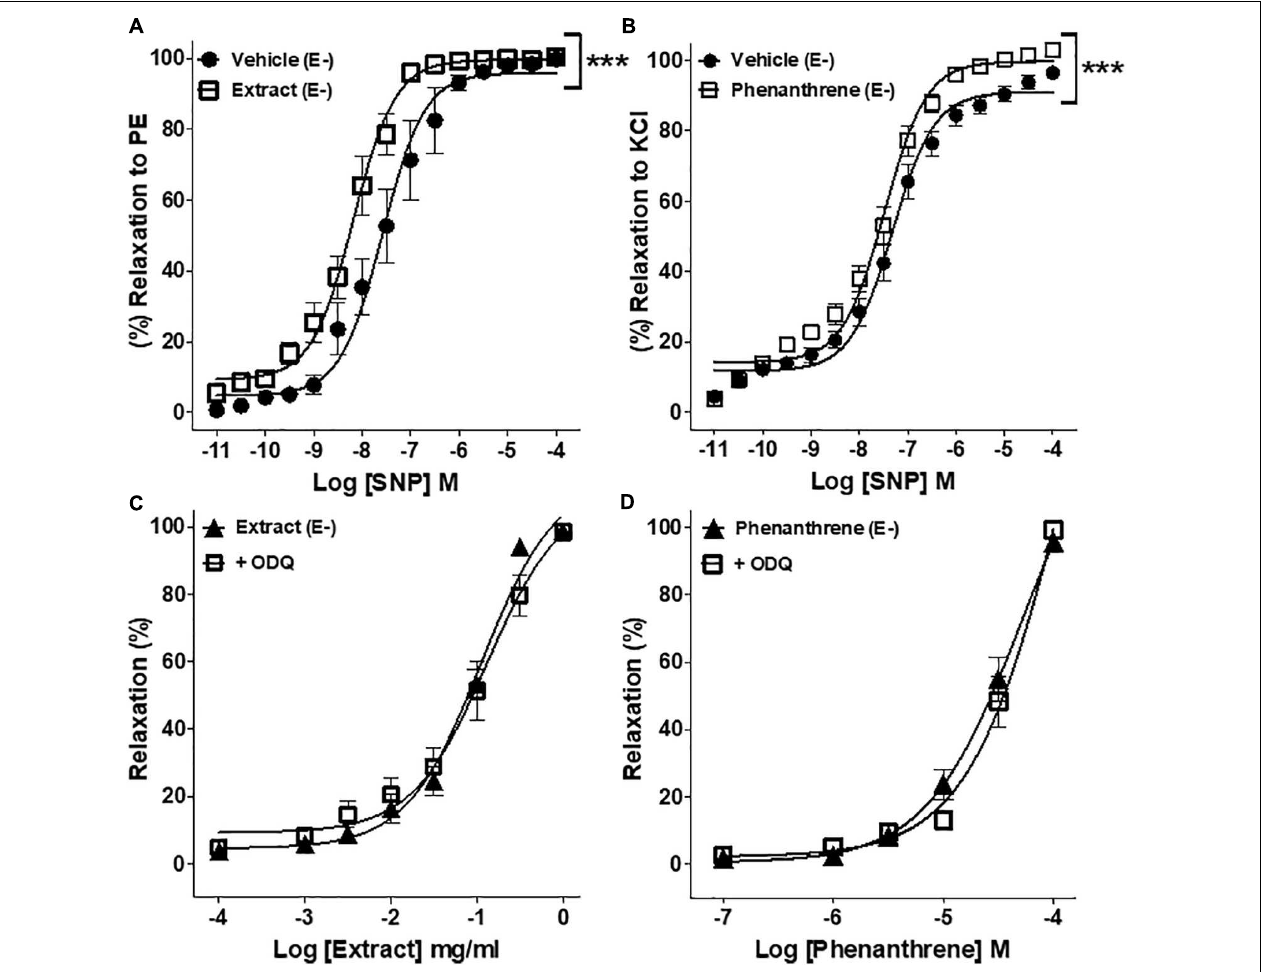
FIGURE 4 | Effect of EM extract or phenanthrene on sGC/cGMP-induced relaxation. Endothelium-denuded (E − ) mesenteric rings pretreated with 125 µ g/ml EM or vehicle and pre-contracted with 10 − 5 M PE (A) , pretreated with 35 µ M phenanthrene or vehicle and pre-contracted with 100 mM KCl (B) followed by relaxations with cumulative concentrations of SNP, a nitric oxide donor. EM extract (C) or phenanthrene (D) -induced relaxation of denuded (E − ) rings pre-contracted with 10 − 5 M PE and pretreated with 10 − 5 M ODQ, sGC inhibitor. Values are means ± SEM of n individual arteries. ∗ p < 0.05, ∗∗ p < 0.01, ∗∗∗ p < 0.001 vs. vehicle (A,B) , vs. Extract (E − ) (C) , or vs. phenanthrene (E − ) (D) , ( n =